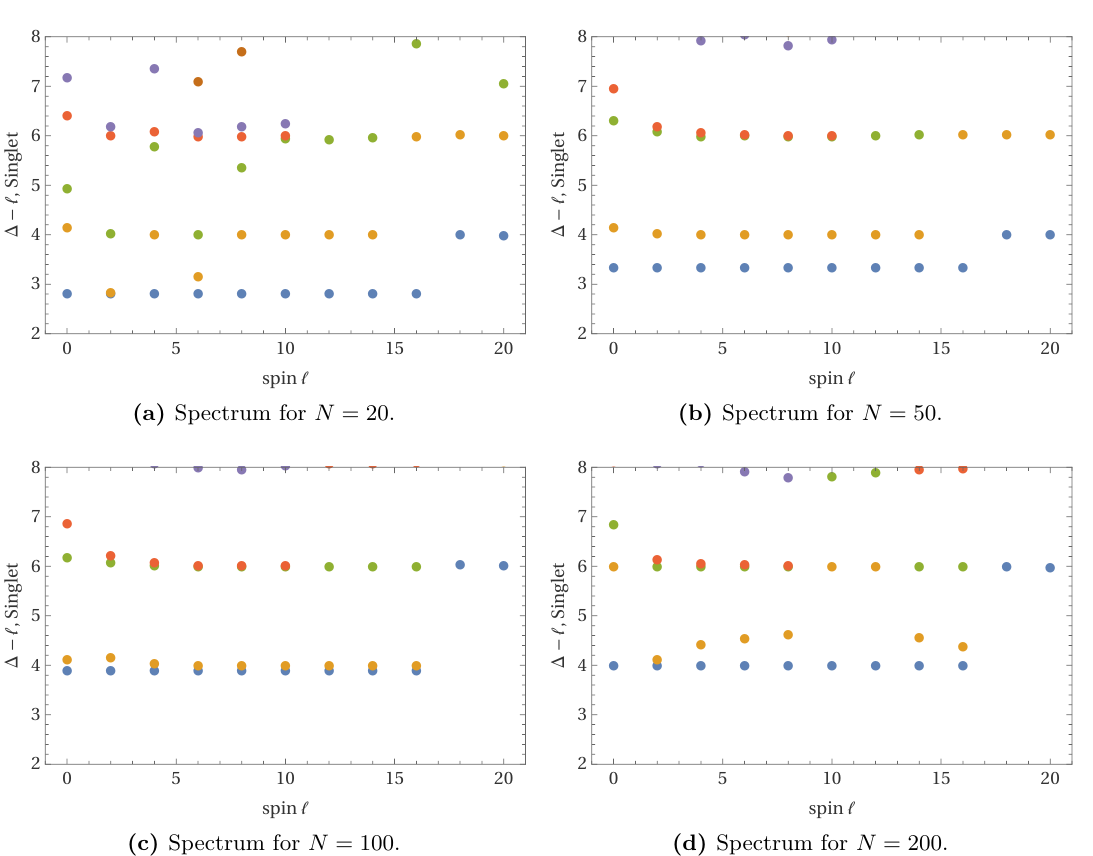
Figure 13. Close-up of the plot in figure 12 retaining only the singlet spectrum. The values of N shown are, from the top left to the bottom right, N = 20 , 50 , 100 , 200 . We used the bound obtained with Λ = 27